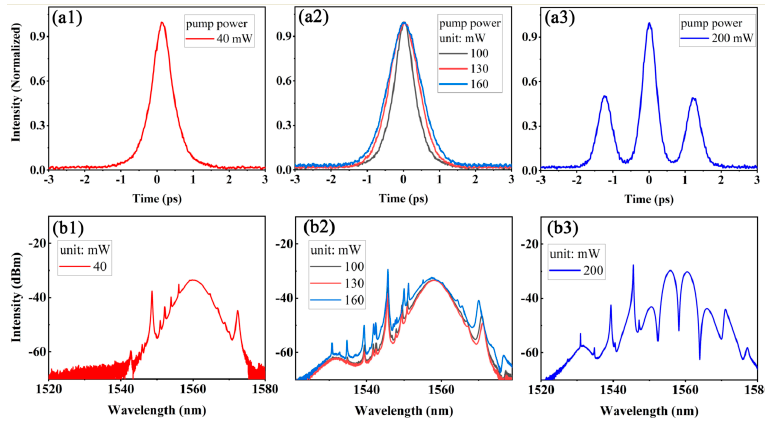
Figure 3. Function of experimental CS behavior with pump power. ( a1 )–( a3 ) CS pulse broadening and breaking-up with increasing pump power from 40 to 200 mW; ( b1 )–( b3 ) the corresponding spectra. In order to confirm the feasibility to switch pulse operation states by significantly changing the SA parameters, we assembled the bilayer CNT-SA in the flange without other modifications. Typical pulse duration and optical spectrum generated by BL CNT-SA are demonstrated in Figure 4a,b. Intriguingly, the spectrum has a triangle shape and the Kelly sideband is not observed. The measured AC trace changes from sech 2 -shape to NLP shape whose AC trace has a unique characteristic of a narrow spike on top of the broad pedestal. The NLP spike widths remain nearly unchanged at 1.75 ps with increasing pump power (inset of Figure 4c) while NLP pedestals broaden from 15 ps to 98 ps. The NLP spectra are centered at 1531 nm as a triangle shape and the 3-dB bandwidth gradually broadens with higher power in Figure 4d. The above results prove the ability to transform the pulse operation states in an Er-doped fiber laser by changing CNT-SA parameters.